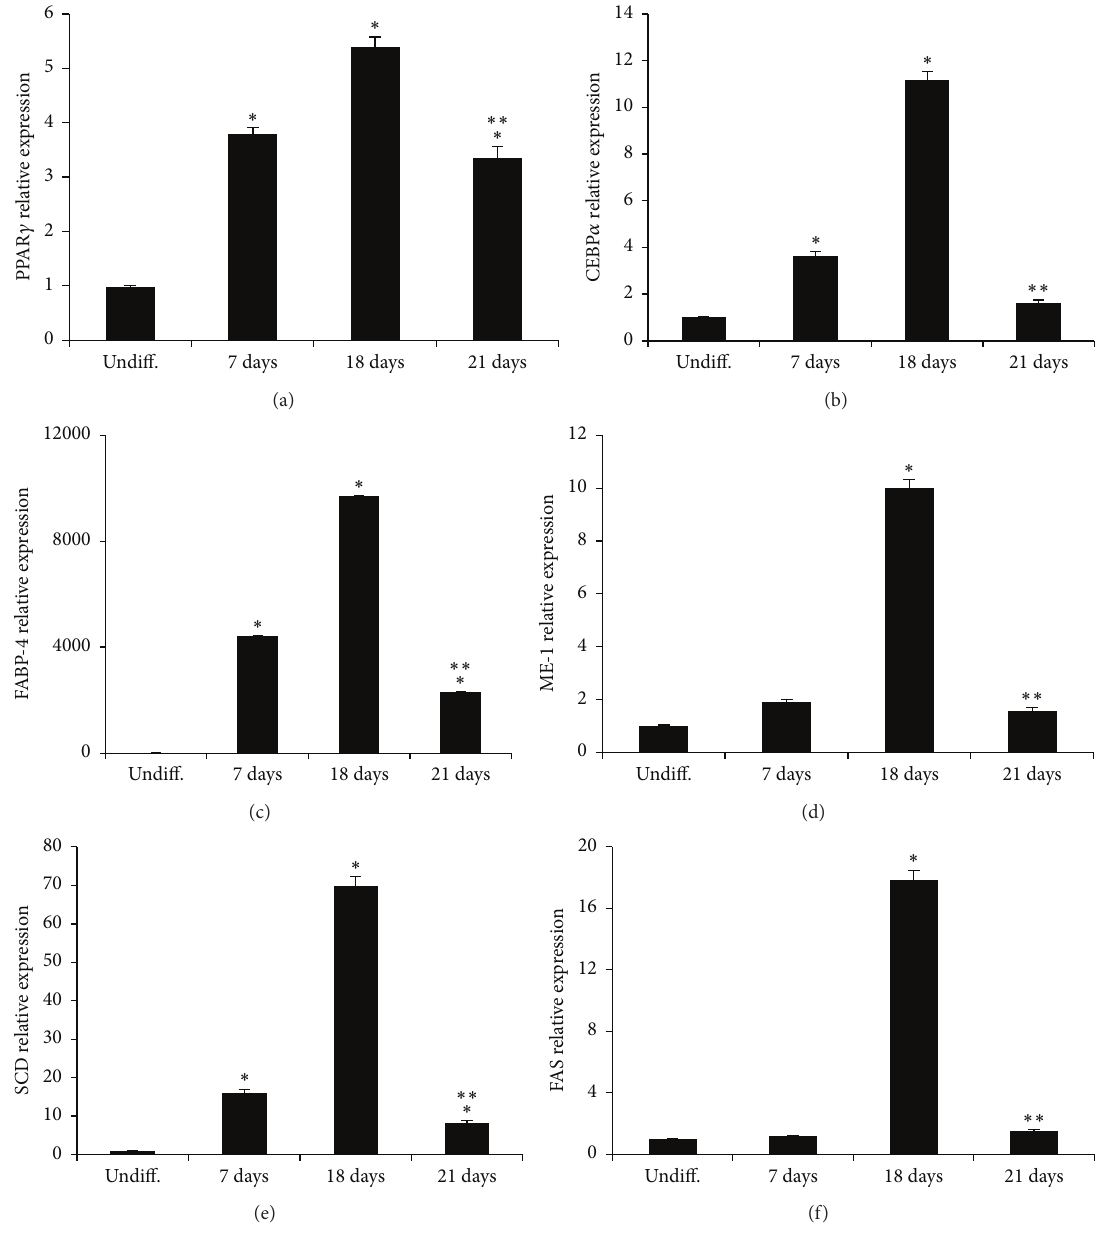
Figure 2: Expression of adipogenic markers during adipogenesis. qRT-PCR revealed a marked increase of PPAR 𝛾 , CEBP 𝛼 , FABP4, ME1, SCD, and FAS at 18 days of adipogenic differentiation. Values represent the means ± SD of 4 experiments performed in triplicate. ∗ 𝑝 < 0.05 , significant result versus undifferentiated cells. ∗∗ 𝑝 < 0.05 significant result versus 18